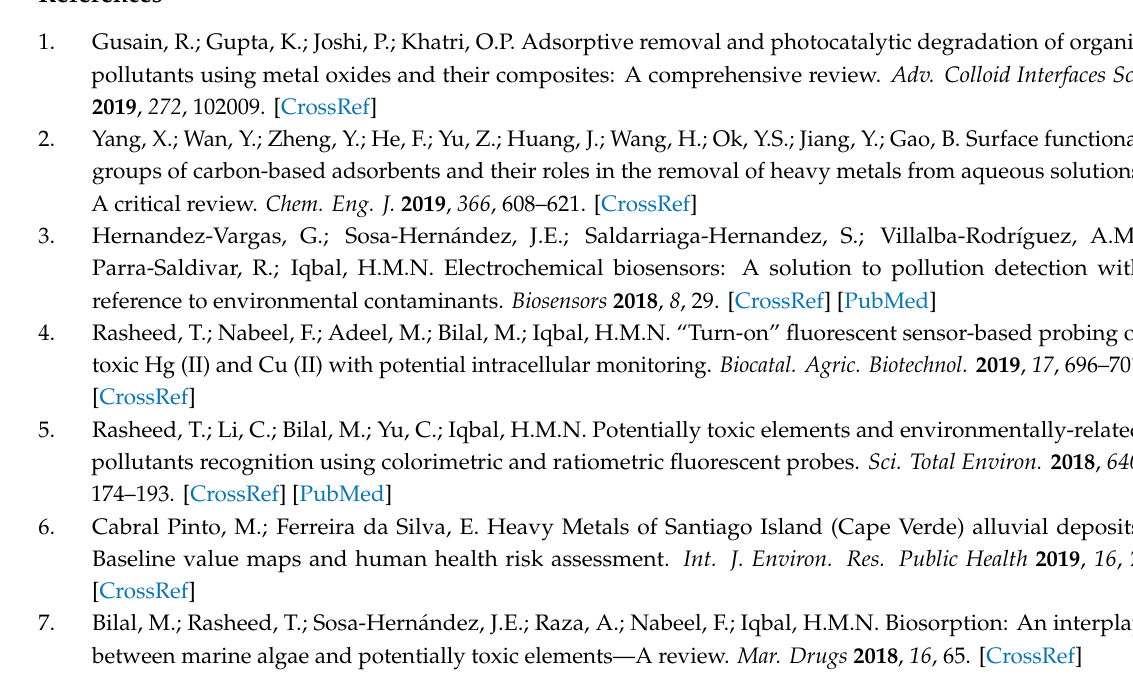
Table 5. Where Nf exp is the moles no. sorbed, Nf calc is the no. of moles found out for every model, m is the no. of points in every isotherm, and P is the no of parameters in every equation